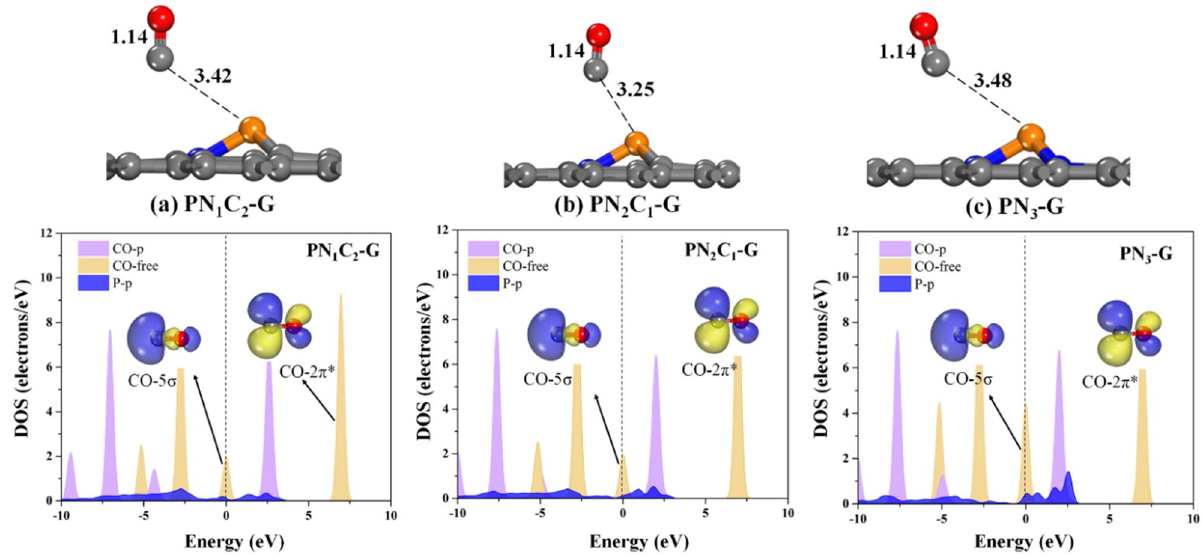
Figure 3. Optimized geometries and corresponding PDOS plots for the adsorption of CO over ( a ) PN 1 C 2 -G , ( b ) PN 2 C 1 -G , and ( c ) PN 3 -G . All bond distances are in Å. In the PDOS plots, the dashed line indicates the Fermi level (E F ) level, which is set to zero.